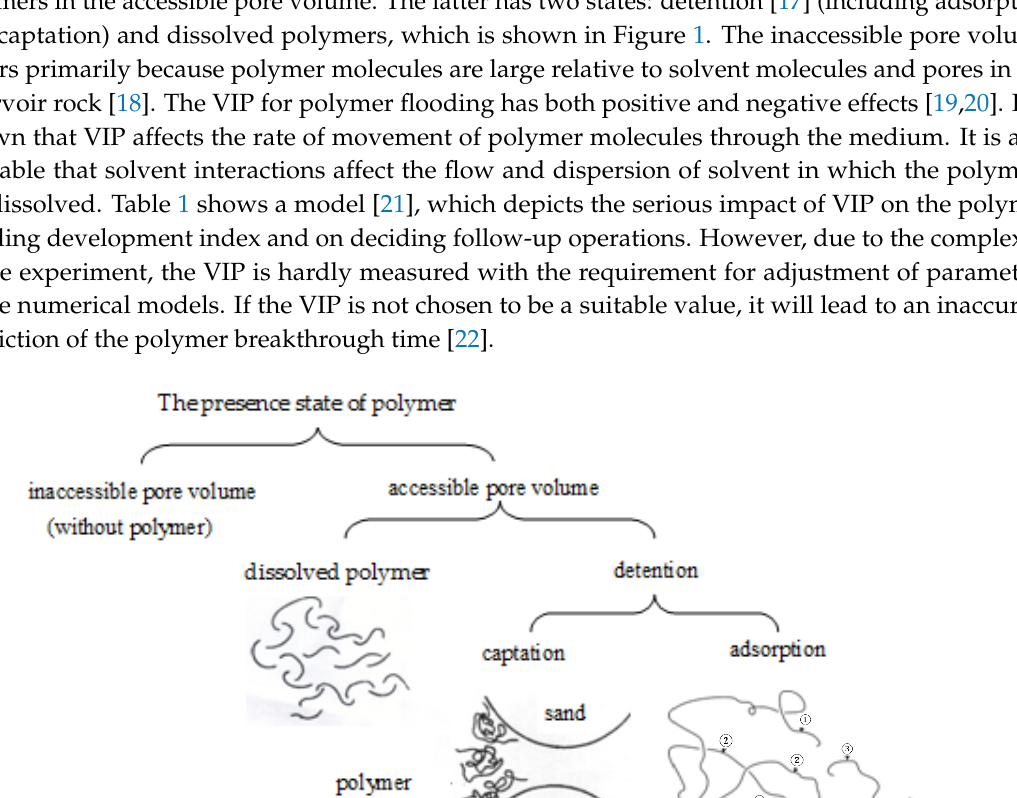
Table 2. The composition of synthetic brine.